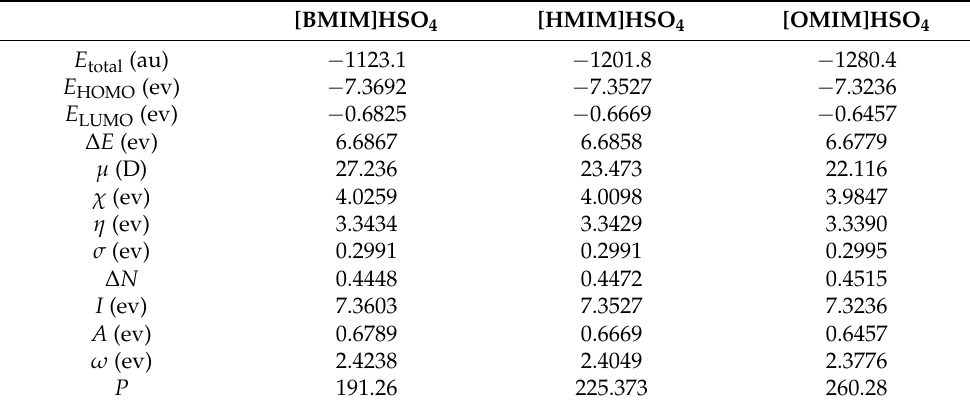
Table 2. Reactive parameters of three ILs in solution obtained with